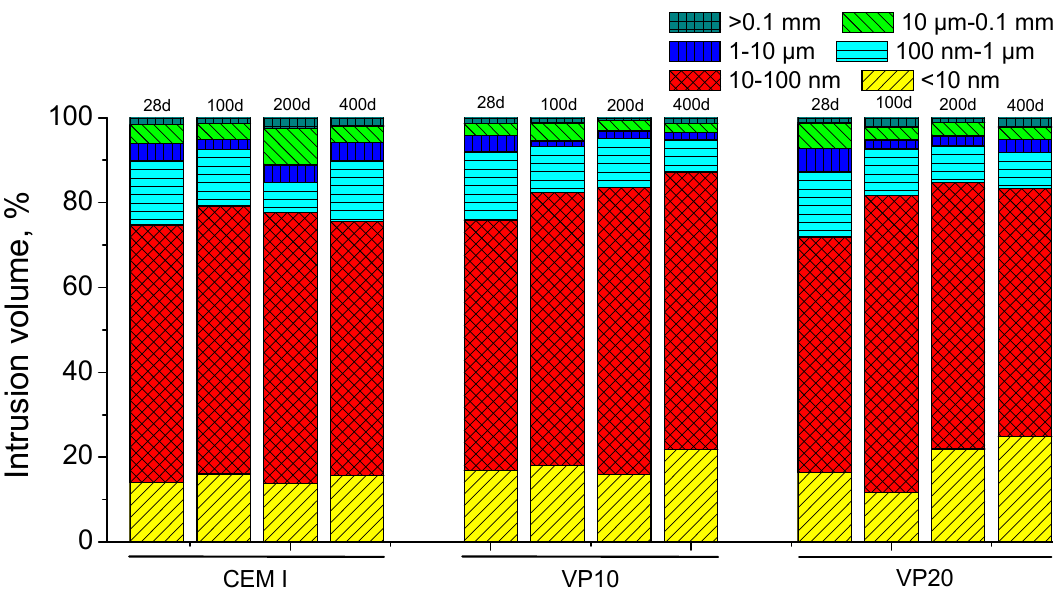
Figure 7. Pore size distribution of the mortars studied.